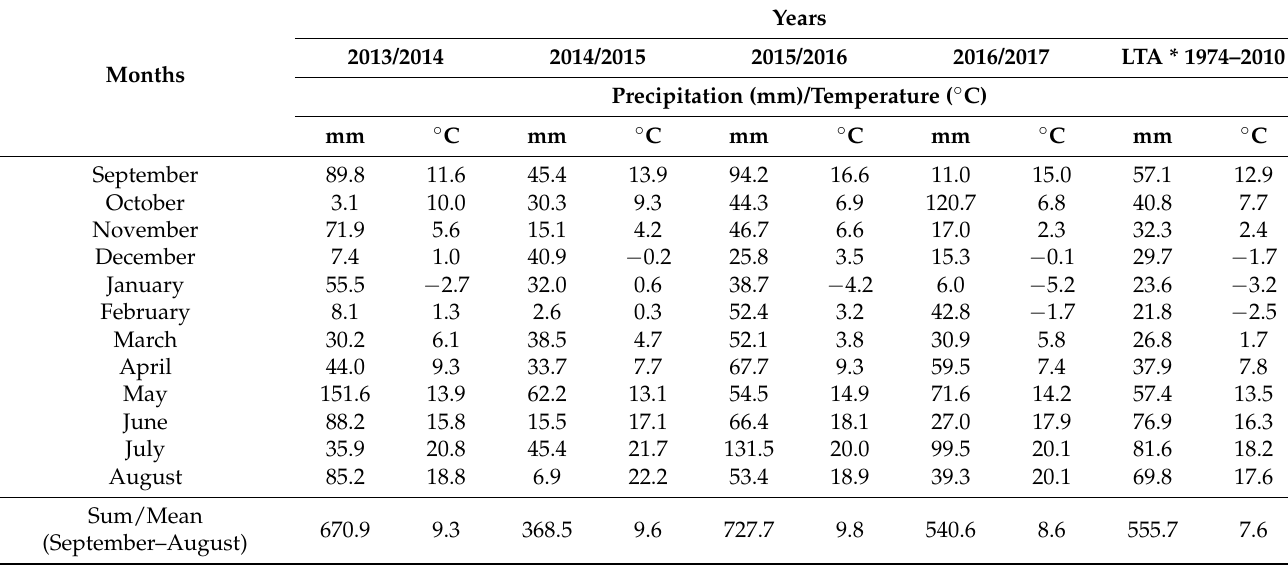
Table 1. Total precipitation and mean monthly air temperature in the growing season of winter wheat, recorded by the Meteorological Station in Bezek